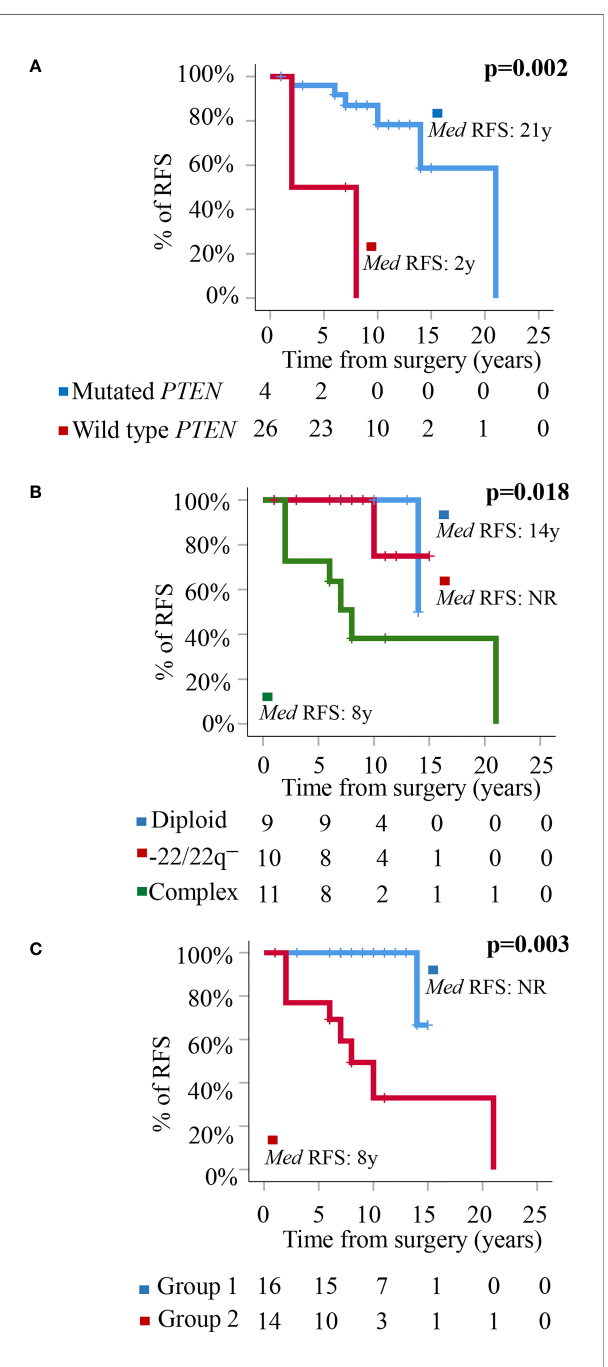
FIGURE 2 | Prognostic impact of PTEN mutation and the cytogenetic and molecular tumor pro fi les in the outcome. (A) Prognostic impact of the presence of genetic variants of PTEN on patient relapse-free survival (RFS). (B) Prognostic impact of the cytogenetic pro fi le of WHO grade 1 meningiomas on patient RFS. (C) Prognostic impact of the overall cytogenetic and mutational pro fi le on RFS of WHO grade 1 meningiomas distributed into a good-prognosis group (Group 1: meningiomas with a diploid karyotype and isolated monosomy 22/22q ─ associated with NF2 mutation) (n = 16) and a poor-prognosis group (Group 2: meningiomas with isolated monosomy 22/ 22q ─ in the absence of NF2 mutations and tumors with a complex karyotype associated or not with mutation of the NF2 gene) (n =